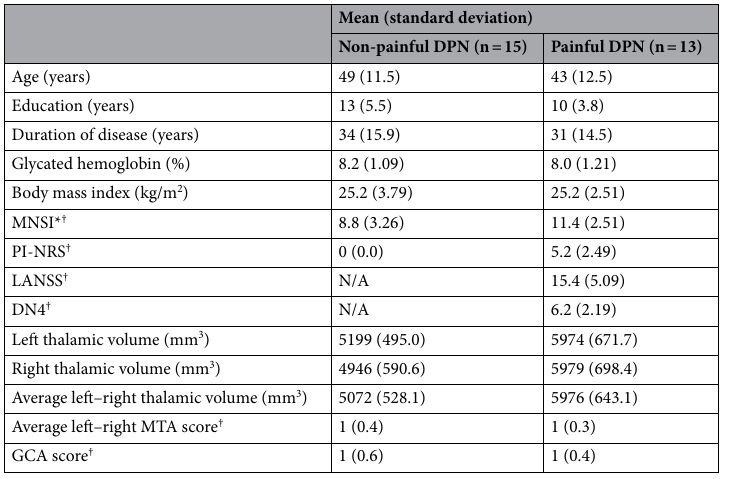
Table 1. Descriptive results for the most relevant variables in patients with type 1 diabetes mellitus and nonpainful versus painful diabetic peripheral neuropathy (DPN), as well as medial temporal lobe atrophy (MTA) and global cortical atrophy (GCA) scores. DN4 Douleur Neuropathique 4, LANSS Leeds Assessment of Neuropathic Symptoms and Signs, MNSI Michigan Neuropathy Screening Instrument, N/A not applicable, PI-NRS 11-point pain intensity numerical rating scale. *Please note that whereas the Mann–Whitney U test revealed a statistically significant difference of median MNSI scores between groups ( P < 0.05), no statistically significant difference was found between the corresponding means; † Please note that means and standard deviations of scores are presented to better illustrate the variability of